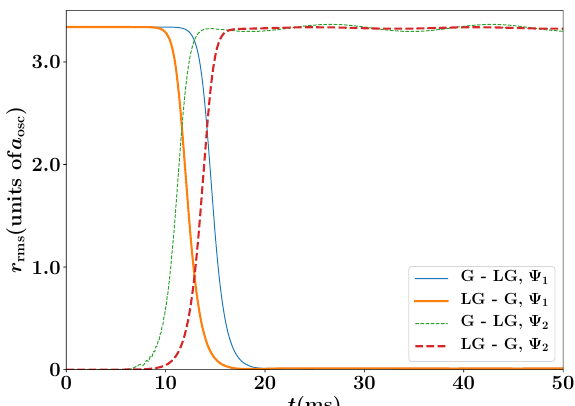
Figure 3. (Color online) Shows the time evolution root mean square radius r rms of BEC Ψ 1 and Ψ 2 for different pulse sequences(see legends). The BECs are confined harmonic trapping potential with frequency ω = 2 π × 30.832 Hz and the intra-and interspecies interactions are taken as a 11 = 100.04 a 0 , a 22 = 95.44 a 0 , and a 12 = 100 a 0 respectively. The dynamics is triggered by employing LG[G]-G[LG] pulse sequence, where LG[G] is the pump beam and G[LG] is the stokes